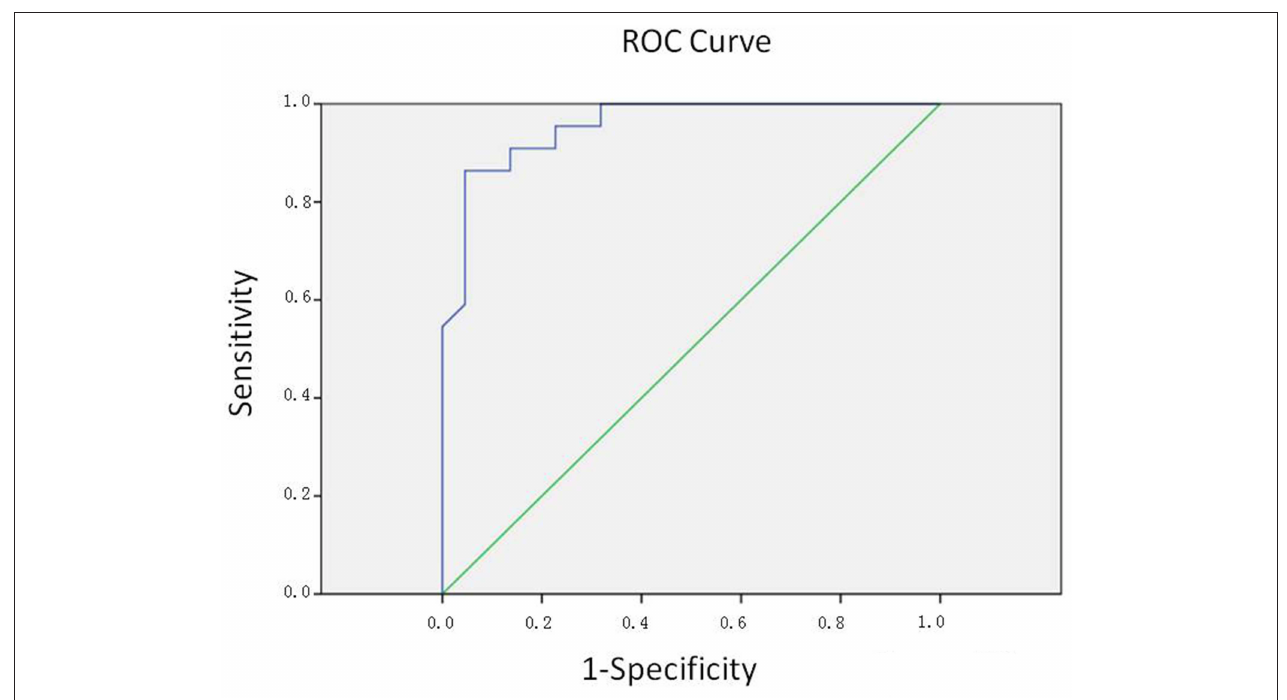
FIGURE 3 | ROC curve. The area under the ROC curve (AUC) is 0.956, indicating a highly accurate